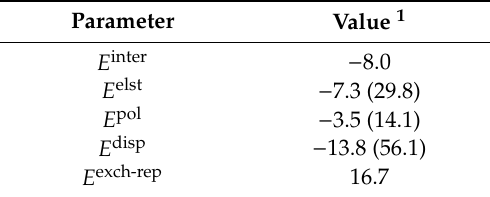
Table 9. Interaction energy and its LMOEDA components for two Fc 2 CS molecules shown in Figure 8. All energies are given in kcal mol − 1